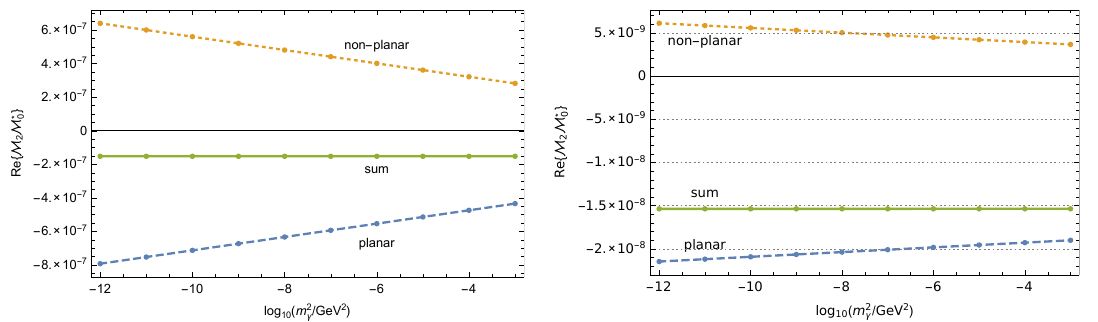
Figure 3. Dependence of the γγ (left) and γZ (right) two-loop boxes on the photon mass m γ . The lines depict linear fits to the data points.